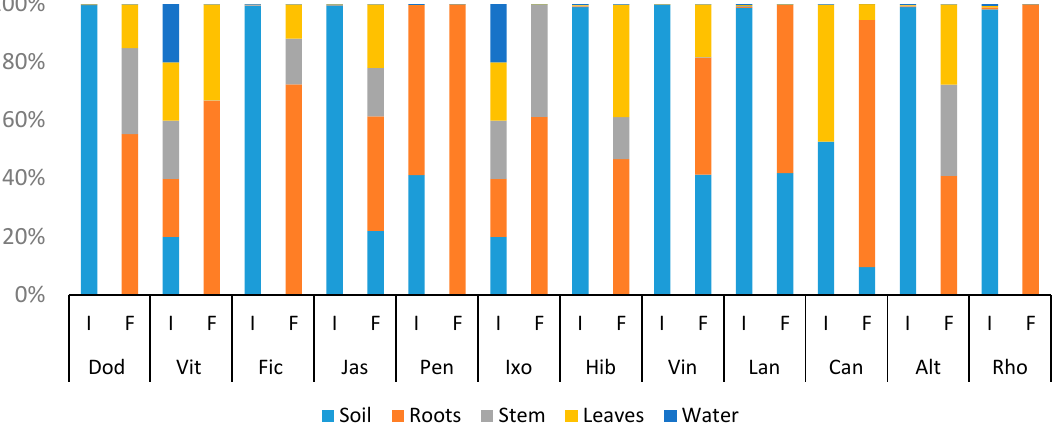
Figure 6. Distribution of Pb in the biofiltration components at the beginning (I, before irrigation with greywater) and at the end (F, after irrigation with greywater) of the experiment.